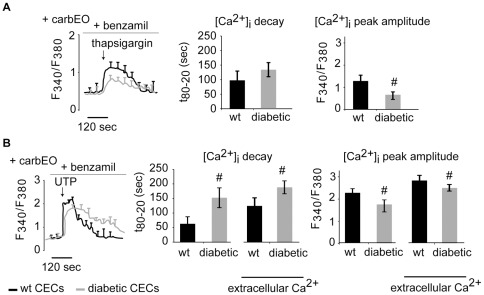
Diabetes alters SERCA-mediated Ca2+ sequestration.Cells were treated with PMCA (carbEO) and NCX (benzamil) inhibitors to study SERCA activity during Ca2+ re-sequestration without the contribution of Ca2+ efflux mechanism. (A): Slow and long-lasting Ca2+ transients were evoked by thapsigargin (in Ca2+ free medium), with no significant difference in decay time between wild-type and diabetic CECs. However the peak amplitude in diabetic CEC was significantly smaller then in wild-type group. (B): UTP-evoked [Ca2+]i transients in diabetic cells had significantly longer decay time and smaller peak amplitude in the absence or presence of extracellular Ca2+ (#: p<0.05; cell no: A: 82 (wt), 76 (db); B: 73 (wt), 78 (db)).